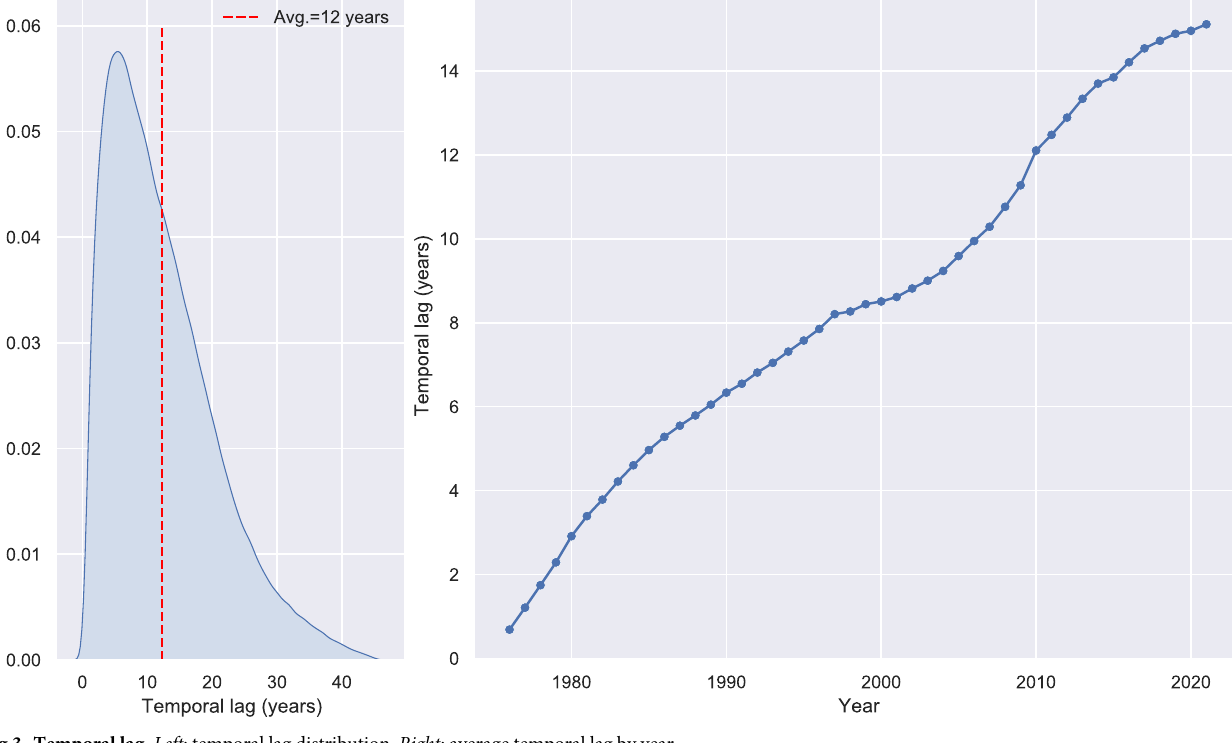
PLOS ONE | https://doi.org/10.1371/journal.pone.0283247 March 20,